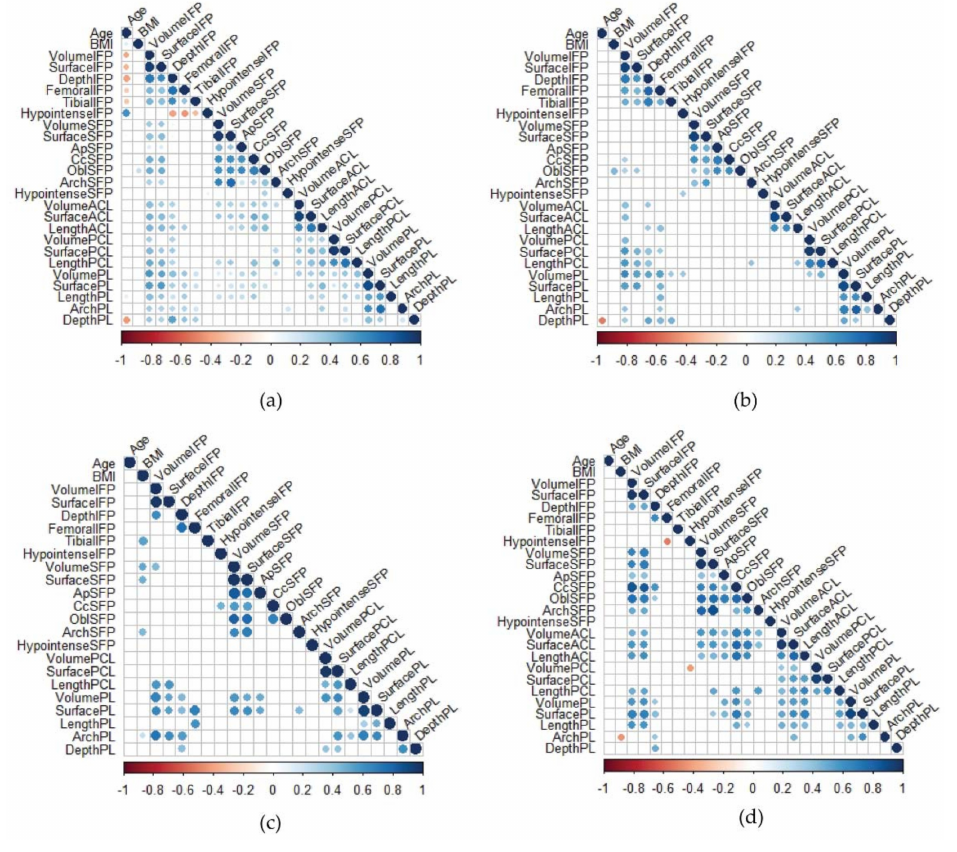
Figure 7. Spearman correlations among the variables. ( a ) all patients, ( b ) meniscal tear patients, ( c ) ACLR patients, and ( d ) end-stage OA patients. Negative correlations are displayed in red color, while positive correlations are in blue. The color intensity and the size of the circle are